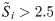
SE for both the left and the right mesial subnetworks for patients J.The x-axis marks the time relative to seizure onset (thick vertical solid line). The vertical dotted lines mark the times when more than five channels reached S˜i>2.5 (see text for explanation). A moving average over ten consecutive windows is displayed with a thick solid black line.